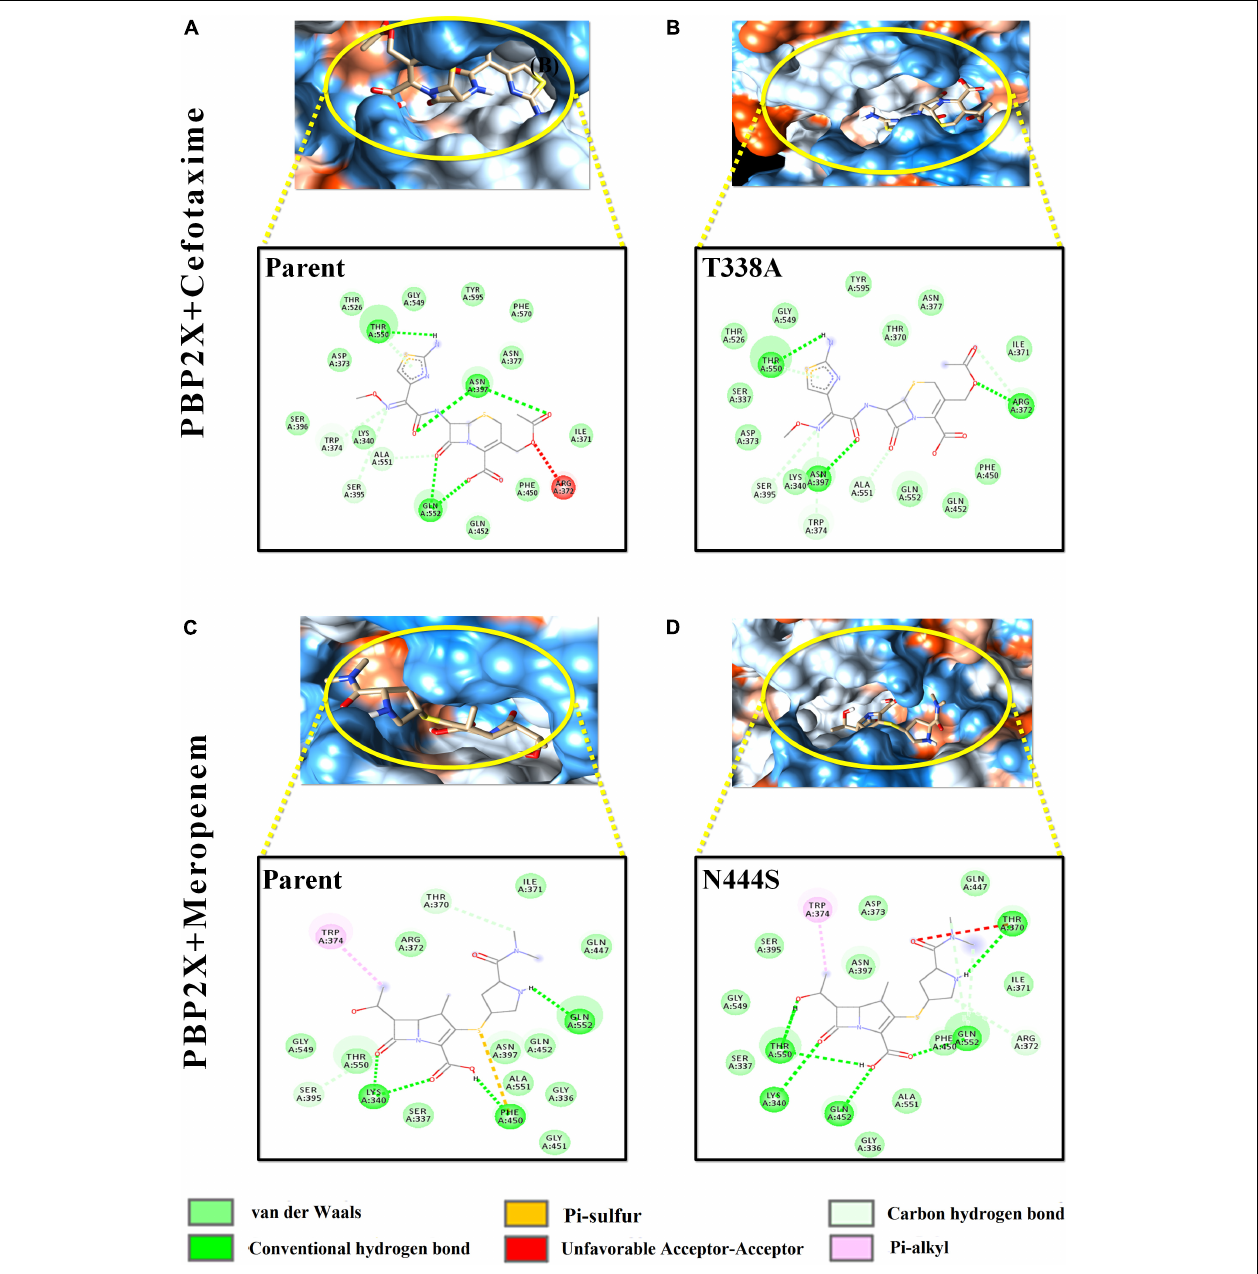
FIGURE 5 | Intermolecular interactions of PBP2X with cefotaxime and meropenem. (A) PBP2X (parent) + cefotaxime, (B) PBP2X (T338A) + cefotaxime, (C) PBP2X (parent) + meropenem, and (D) PBP2X (N444S) + meropenem.